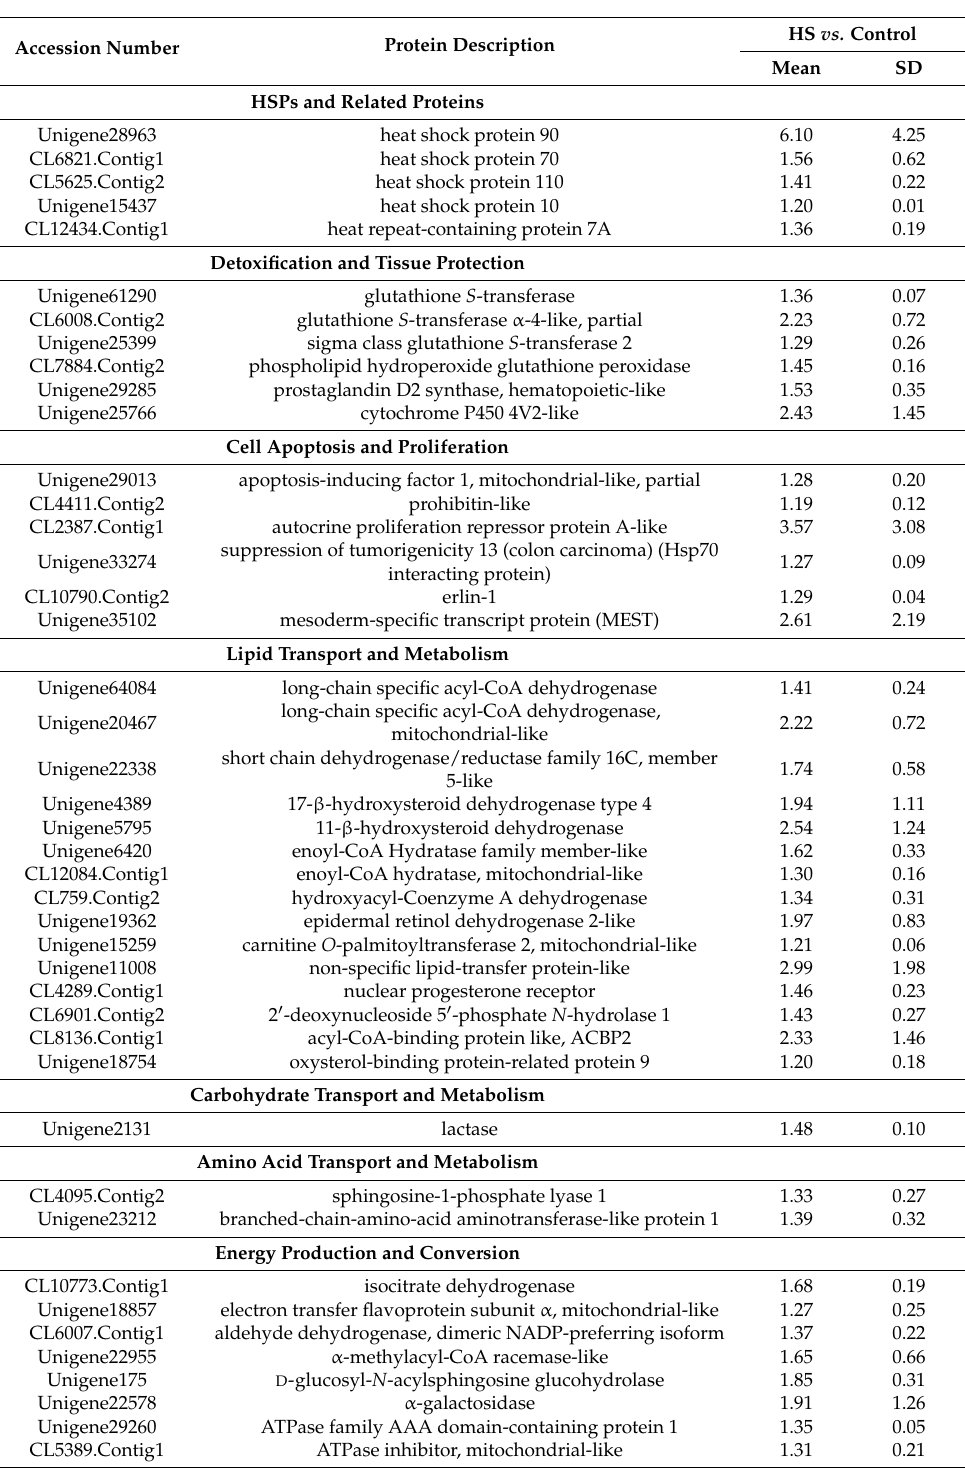
Table 2. Sixty-one upregulated proteins under heat stress in the intestine of the sea cucumber A. japonicas